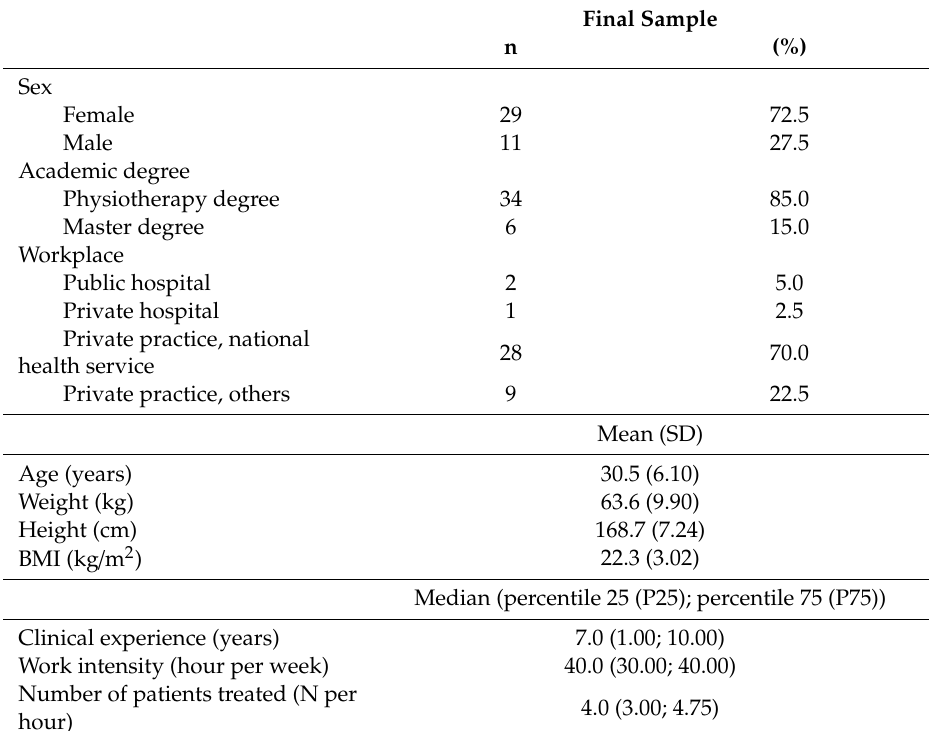
Table 1. Personal and professional characteristics of the